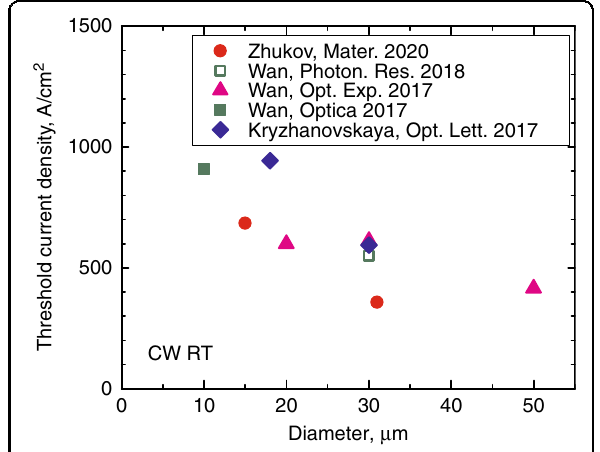
Fig. 16 Energy consumption per bit. Energy-to-data ratio estimated from modulation characteristics against bias current: symbols — experiment (QWD-on-GaAs), lines — modeling with self-heating (solid line) or without (dashed line)